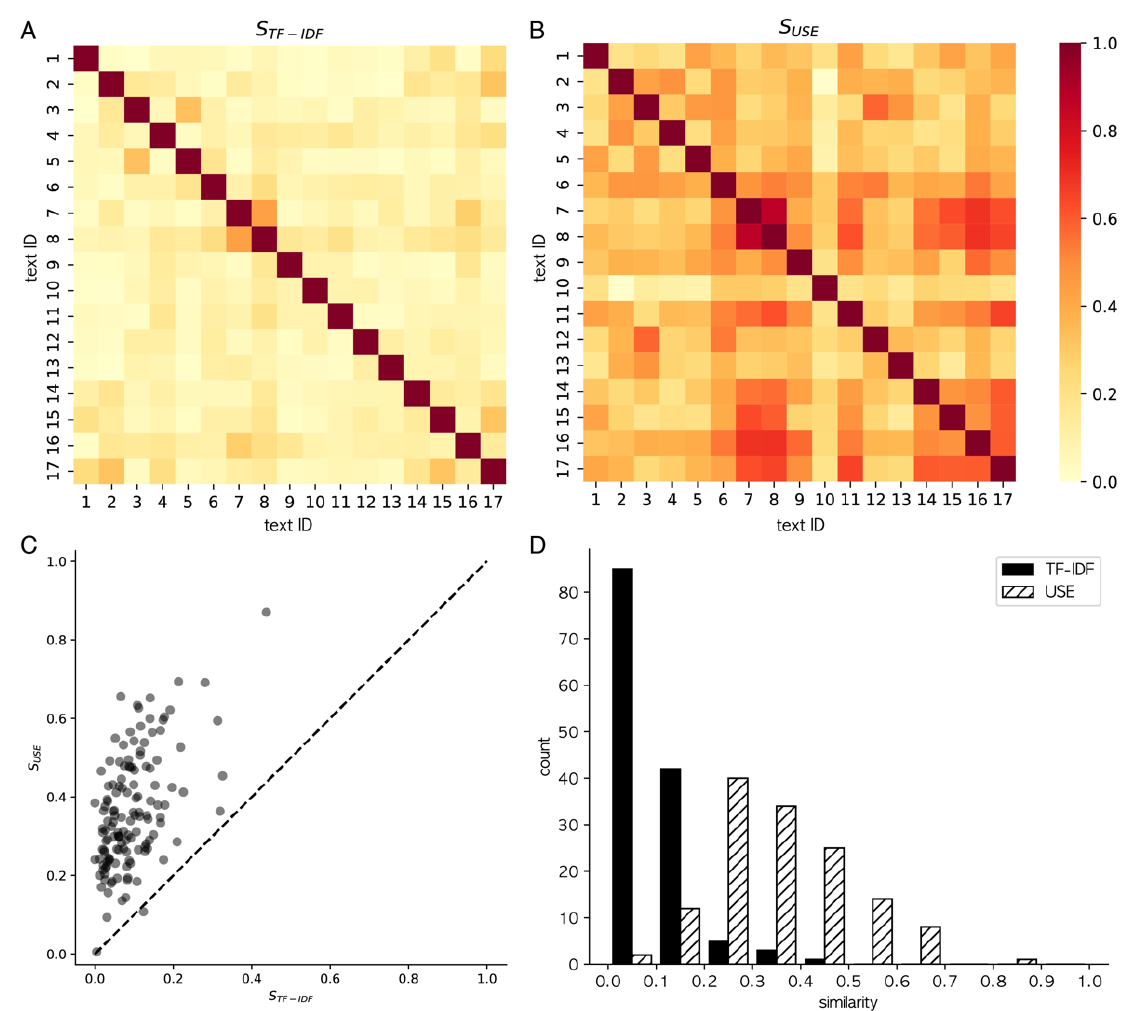
Figure 3. Comparison of the similarity measures based on word frequency ( S TF − IDF ) and contextu- alized embedding ( 𝑆 (cid:2905)(cid:2903)(cid:2889) ) . In ( A , B ), the similarity values of 𝑆 (cid:2904)(cid:2890)(cid:2879)(cid:2893)(cid:2888)(cid:2890) and 𝑆 (cid:2905)(cid:2903)(cid:2889) are shown, respec- tively, for each pair of proposal texts. In ( C ), the similarity values of 𝑆 (cid:2904)(cid:2890)(cid:2879)(cid:2893)(cid:2888)(cid:2890) and 𝑆 (cid:2905)(cid:2903)(cid:2889) are com- pared on a scatter plot. In ( D ), the histograms of 𝑆 (cid:2904)(cid:2890)(cid:2879)(cid:2893)(cid:2888)(cid:2890) (solid) and 𝑆 (cid:2905)(cid:2903)(cid:2889) (dashed) are compared. However, 𝑆 values were smaller (mean: 0.09; standard deviation: 0.07) than (cid:2904)(cid:2890)(cid:2879)(cid:2893)(cid:2888)(cid:2890) 𝑆 values (mean: 0.36, standard deviation: 0.14), which was a statistically significant (cid:3022)(cid:3020)(cid:3006) difference ( p < 10 (cid:2879)(cid:2877) , paired t -test). USE was more informative than TF-IDF for comparing text proposals. As shown in Figure 3D, the histogram of 𝑆 was skewed toward zero, with a median of 0.08, in- (cid:2904)(cid:2890)(cid:2879)(cid:2893)(cid:2888)(cid:2890) dicating that most of the 𝑆 values were near zero, as highlighted by the small off- (cid:2904)(cid:2890)(cid:2879)(cid:2893)(cid:2888)(cid:2890) diagonal values present in Figure 3A. In contrast, the histogram of 𝑆 was more sym- (cid:2905)(cid:2903)(cid:2889) metrical (Figure 3D), with a median of 0.35, close to its mean (0.36). Thus, this wider range of 𝑆 allows one to distinguish semantically different texts from others. (cid:2905)(cid:2903)(cid:2889)